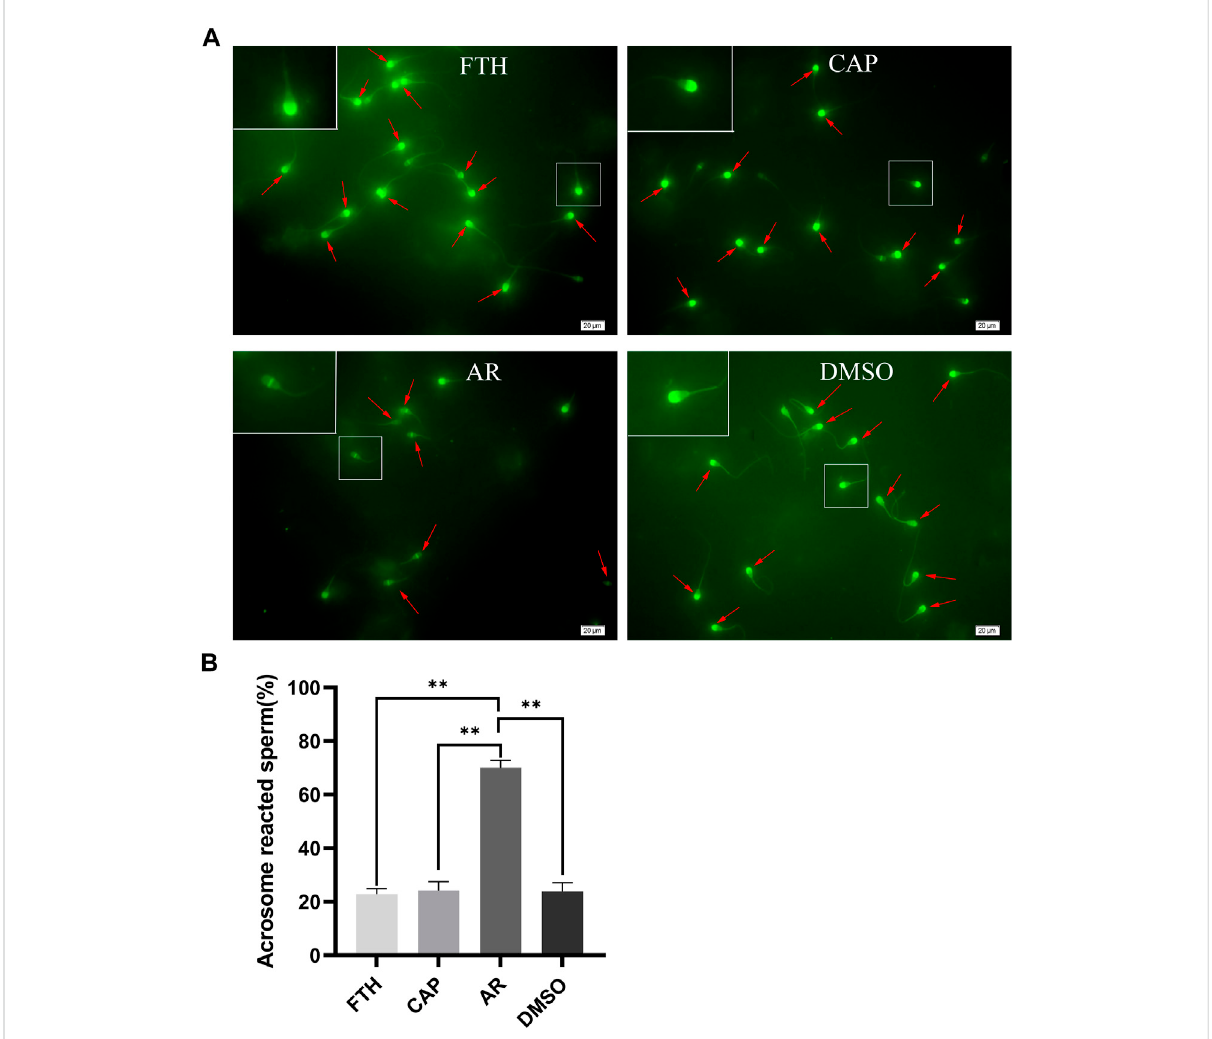
The analysis of acrosome integrity based on PSA-FITC Labeling. (A) Representative images of PSA-FITC-labeled frozen-thawed sperm in yak. Sperm were isolated by 45% – 90% Percoll density gradient centrifugation (FTH, upper left), incubated in the capacitation medium containing 50 µg/ ml heparin and 5 mM caffeine (CAP, upper right), and treated with the calcium ionophore A23187 to induce AR (AR, lower left). DMSO (lower right) served as a vehicle control. The inset white squares denote magni fi ed sperm; arrows mark acrosomal caps; scale bar, 20 µm. (B) The quanti fi cation of the number of sperm with reacted acrosomes in the indicated samples after PSA-FITC labeling (** p <